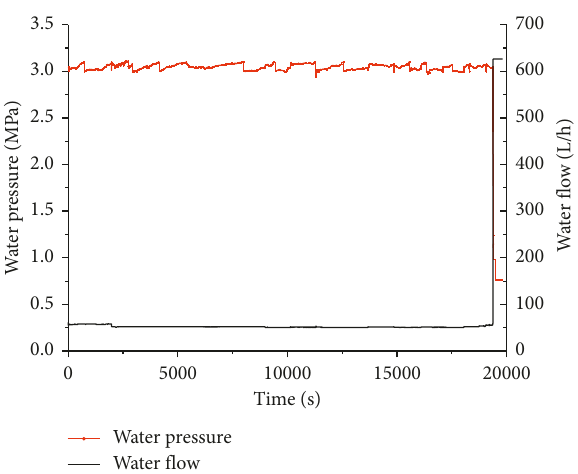
Figure 8: The experimental process.